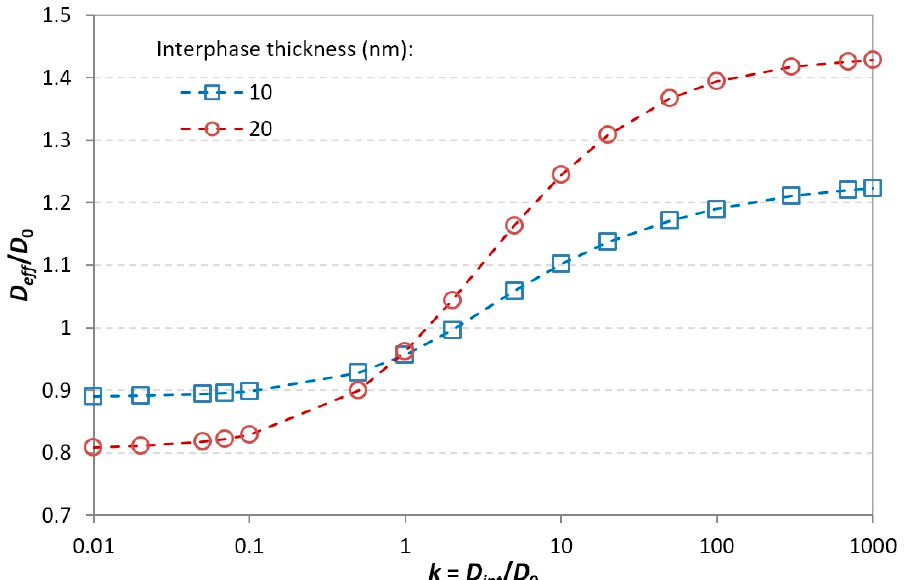
Figure 12. Effects of the filler–matrix interphase thickness and diffusivity on the nanocomposite’s relative effective diffusivity for 2% filler volume fraction .